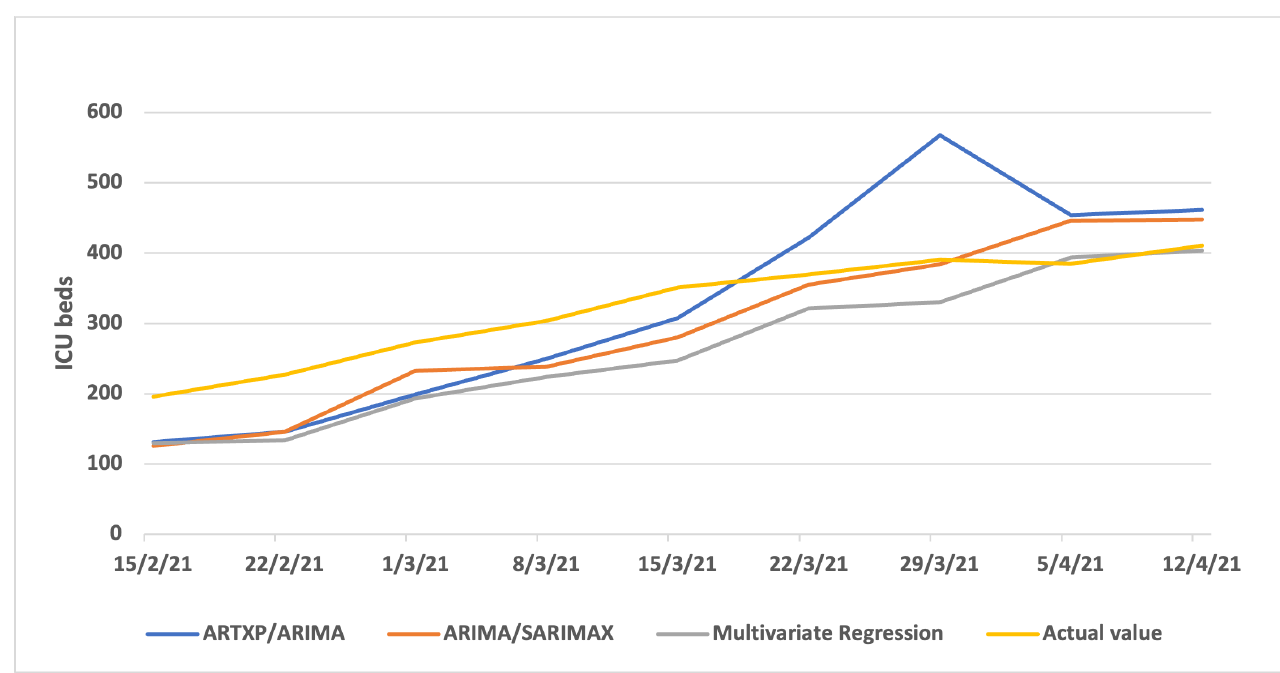
Figure A11. Two weeks Predicted vs. Actual ICUs—Attica.